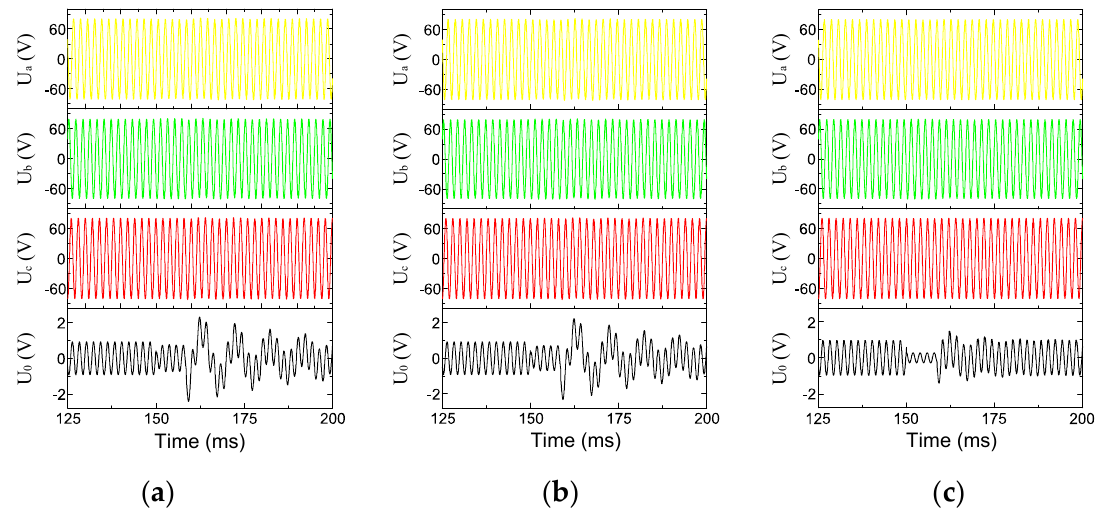
Figure 9. Voltage waveforms. ( a ) R = 0 Ω; ( b ) R = 200 Ω; ( c ) R = 5 kΩ.